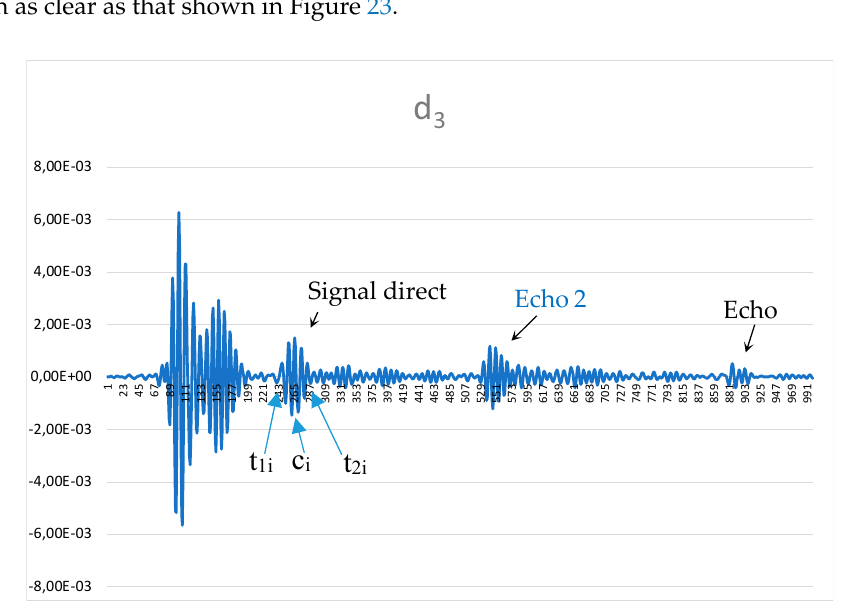
Figure 21. Signal obtained in the receiver configured according to the new magnetostrictive transducer with pre-magnetized strip Ch4: [5 mV/div]. Ch1 shows the activation signal of the power stage [2 V/div] and Ch3 the voltage at resonant circuit [100 V/div]. The maximum AC current is 5 A.